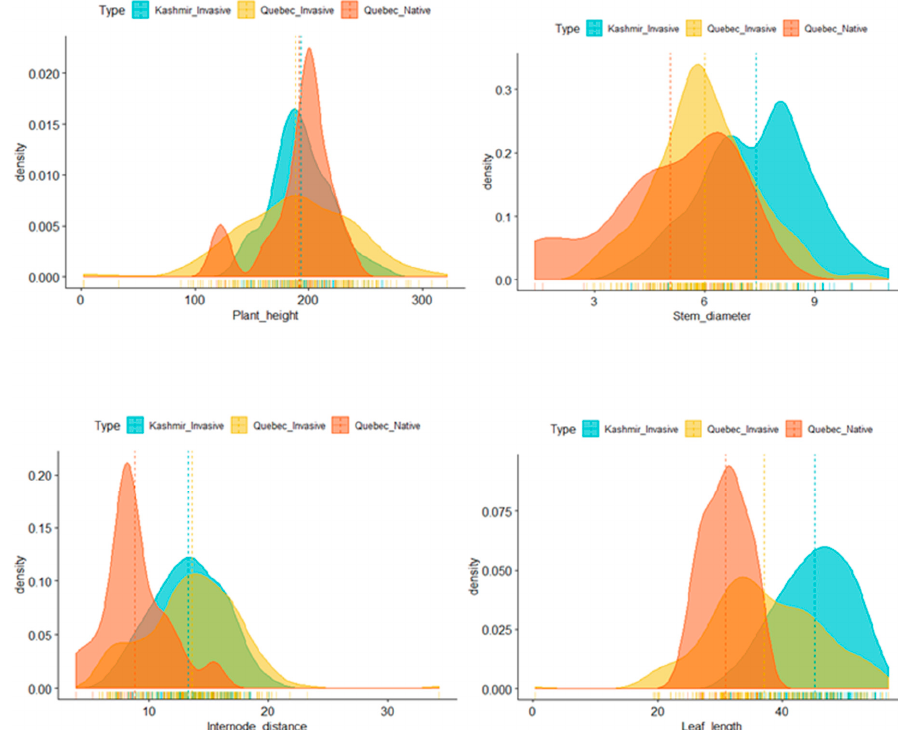
Figure 2. Distribution of phenotypes for the plant height ( upper left ), stem diameter ( upper right ), leaf length ( bottom left ), and leaf width ( bottom right ) are represented by histogram based on the average phenotype value of each Phragmites plants across different environments.